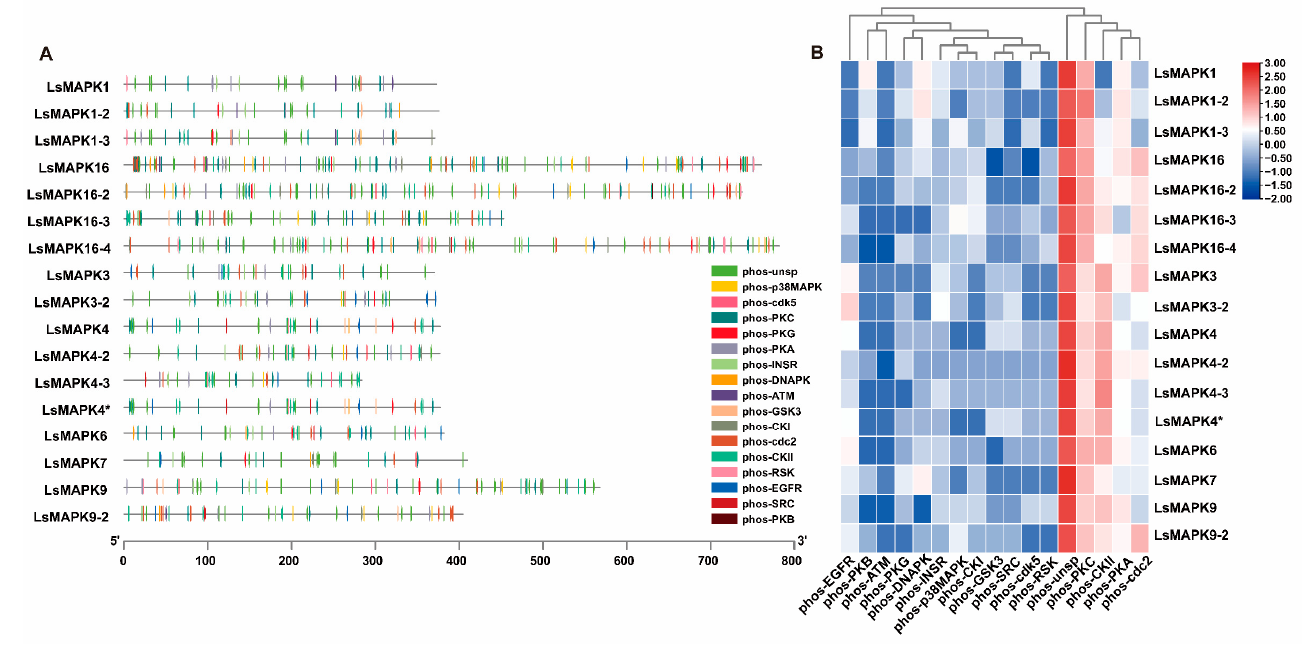
Figure 8. Prediction of phosphorylation sites of LsMAPKs . ( A ) Distribution of phosphorylation sites of protein kinases in LsMAPKs . ( B ) Quantitative heatmap of protein kinases at phosphorylatable sites.